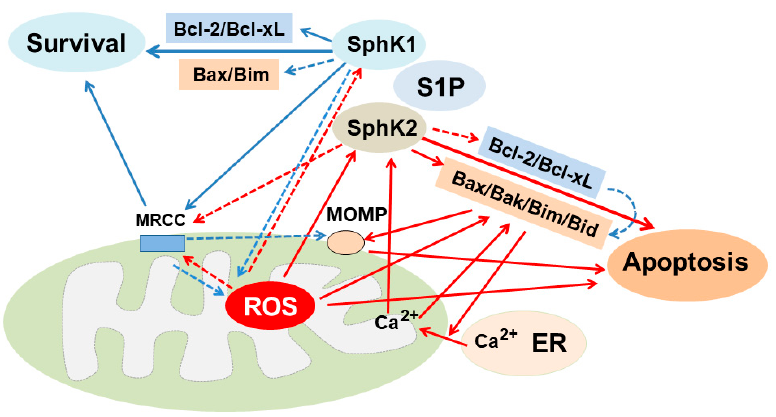
Figure 6. Mitochondria regulate S1P-induced cell survival. SphK1 promotes survival, while SphK2 has the opposite effect. ROS inhibits SphK1/S1P and vice versa. SphK1 prevents ROS-induced apoptosis by preserving MRCC which inhibits MOMP and restores mitochondrial function, leading to a reduction in ROS production, upregulating anti-apoptotic Bcl-2/Bcl-xL and downregulating apoptotic Bax/Bim, while SphK2 has the opposite effect. SphK2 cooperates with C8-BID to stimulate Bax and MOMP, leading to apoptosis, which is inhibited by Bcl-xL. SphK2 activates and inhibits apoptotic Bak and anti-apoptotic Bcl-2 proteins (Bcl-2/Bcl-xL), respectively. SphK2 interacts with Bcl-xL, leading to the suppression of its anti-apoptotic effects. ROS-induced activation of SphK2 induces Ca 2+ release from the ER, which is dependent on Bax/Bak and dispensable for SphK2 activation, leading to the activation of Bax/Bak and apoptosis. Red arrow; apoptotic pathway, blue arrow; anti-apoptotic pathway, → ; stimulation, dashed arrow; inhibition.